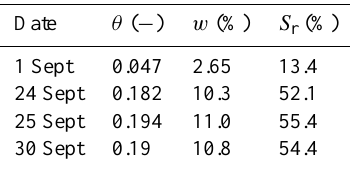
Table 2. Resulting average volumetric–gravimetric water content ( θ and w , respectively) and degree of saturation ( S r ) at four different simulation times (1, 24, 25 and 30